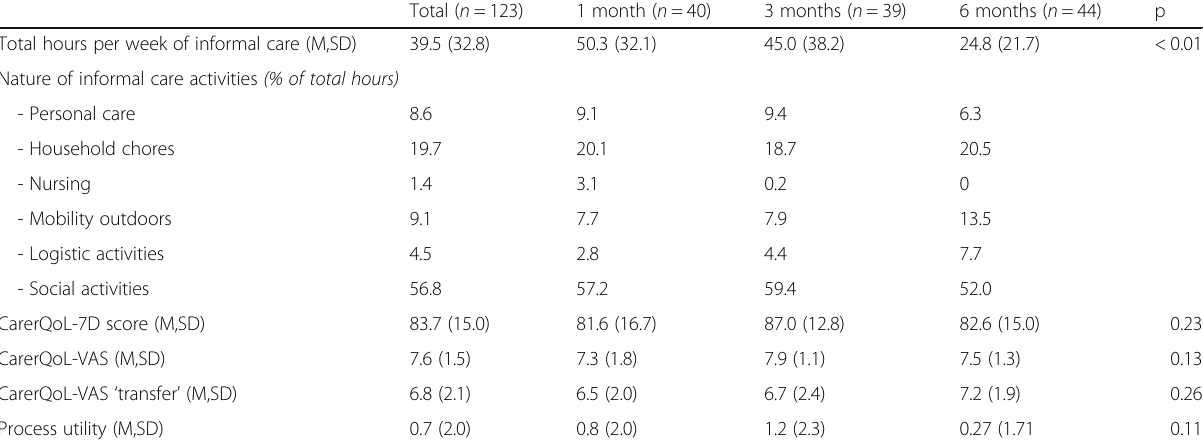
Table 2 Intensity of informal care provided by nature of care for hip fracture patients and CarerQoL-score Total ( n = 123) 1 month ( n = 40) 3 months ( n = 39) 6 months ( n = 44) p Total hours per week of informal care (M,SD)